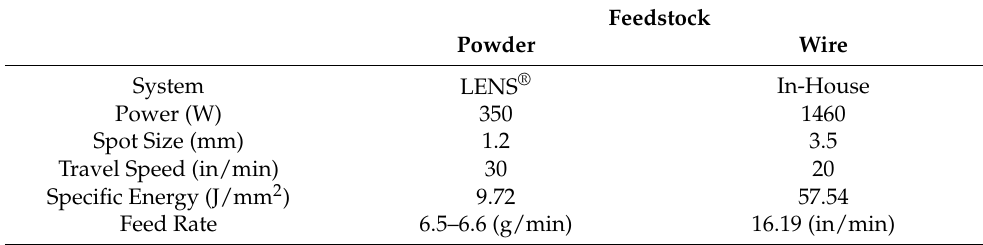
Table 4. Process parameters used in the powder- and wire-fed L-DED processes.